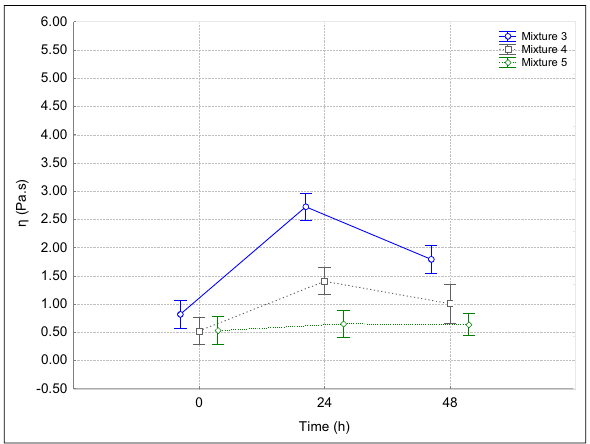
Figure 6: ANOVA: E ff ect of stabilization times on the apparent viscosity of